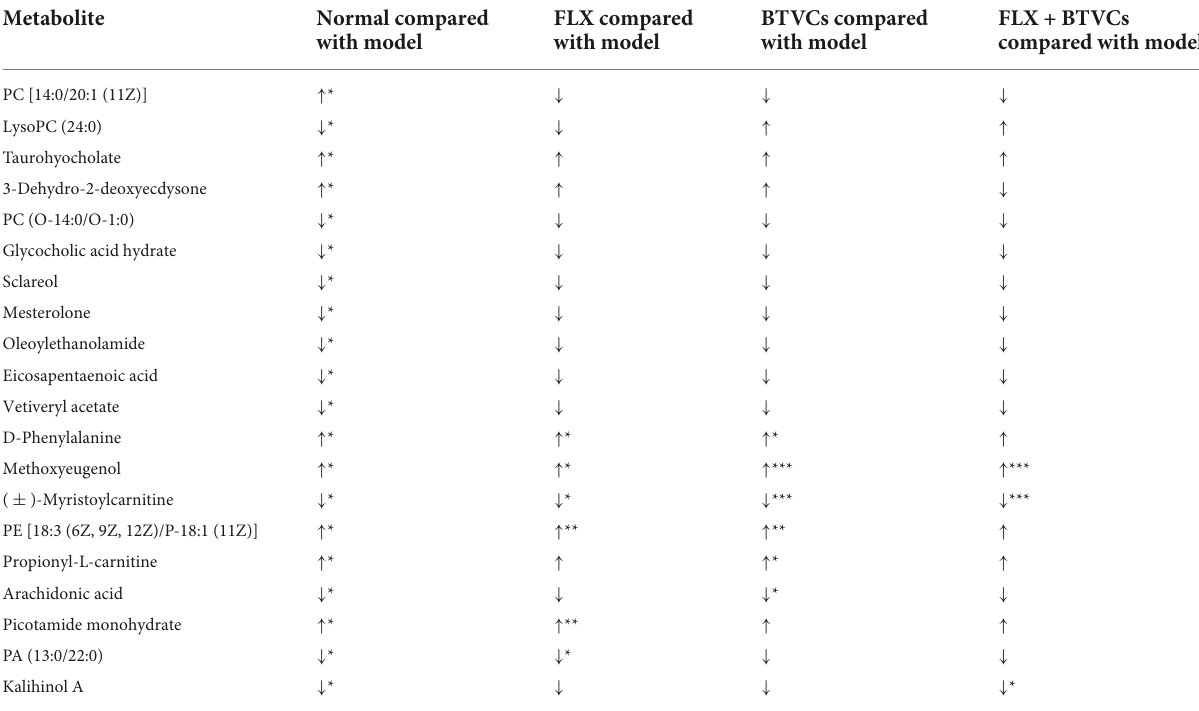
TABLE 1 Serum metabolites with significant changes in treated rats. Metabolite Normal compared